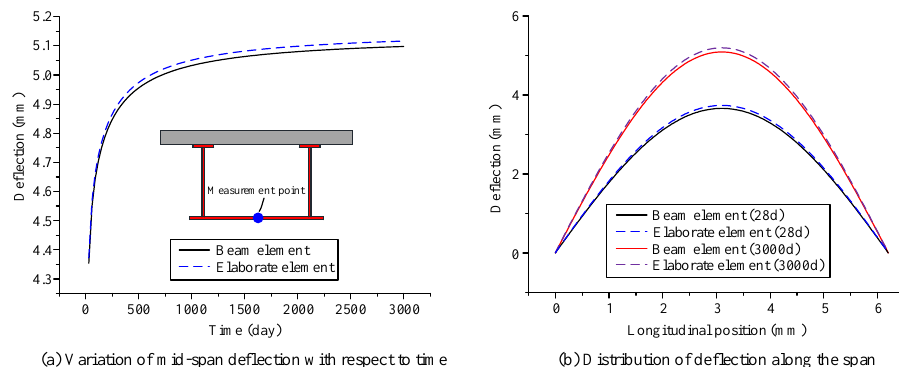
Figure 4. Deflection variation in curved composite box girder, with respect to time: ( a ) variation of mid-span deflection with respect to time, ( b ) distribution of deflection along the span.